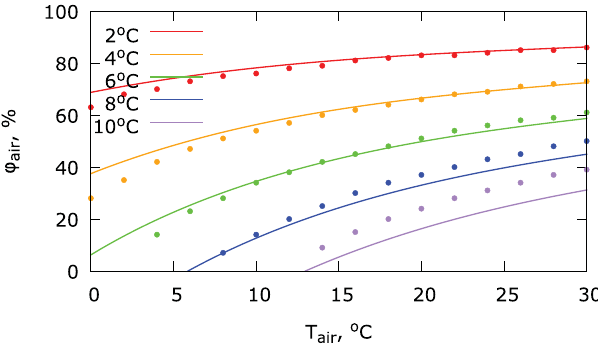
Fig. 4. Data from the psychrometric table (circles) overplotted with the theoretical formula – equation (7) (solid lines). The table shows humidity f air versus temperature T air of the exterior air (dry thermometer) . Different temperature differences D T between the dry and the wet thermometer are plotted in different colours.